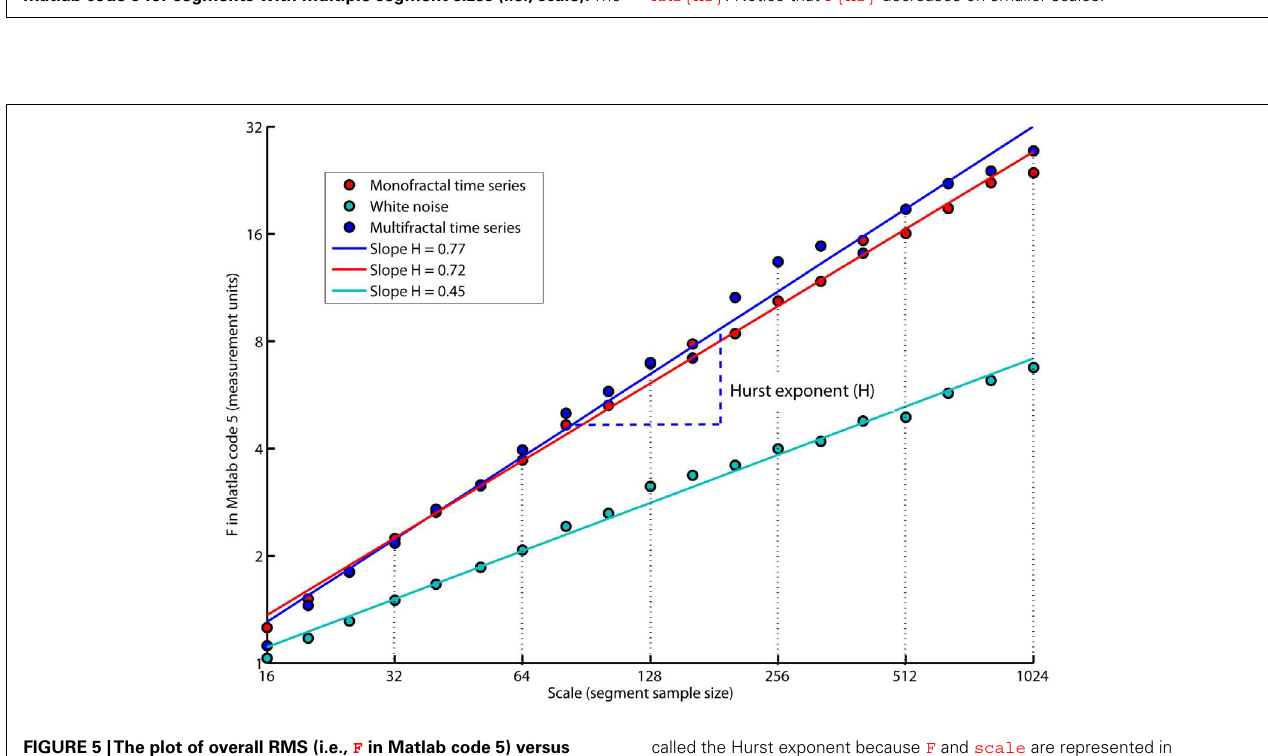
FIGURE 5 |The plot of overall RMS (i.e., F in Matlab code 5) versus the segment sample size (i.e., scale in Matlab code 5) where both F and scale are represented in log-coordinates. The scale invariant relation is indicated by the slope, H , of the regression lines, RegLine , computed by Matlab code 6.The slope, H , is a power law exponent